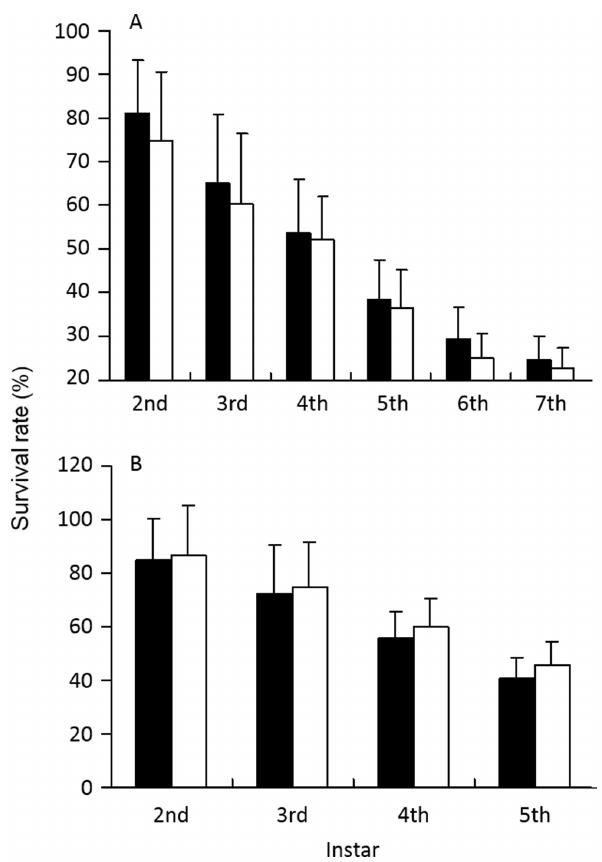
Figure 1. Survival rate of a) Pardosaastrigera and b) Hylyphantes graminicola reared with live (shaded bars) and dead (white bars) prey.